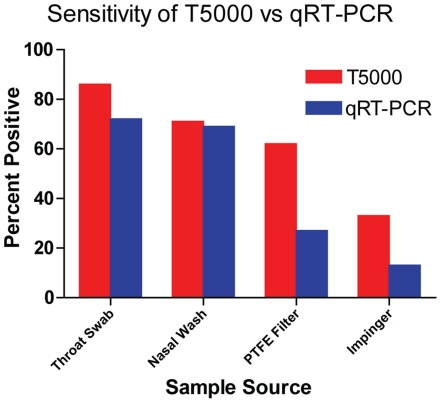
Comparison of sensitivity of the T5000 and RT-PCR Assays.Comparison of sensitivity of the assays for samples expected to contain relatively higher concentrations (3.0 to 7.0 log10 Geq) of viral RNA (throat swab and nasal wash) and relatively lower concentrations (1.0 to 4.0 log10 Geq) of viral RNA. The Ibis T5000 Influenza assay was not significantly more sensitive for detecting viral RNA in the airway specimens under the conditions of this experimental infection, but was significantly more sensitive in detection viral RNA in filter and impinger aerosol collection devices (Chi-Squared test, p<0.01).